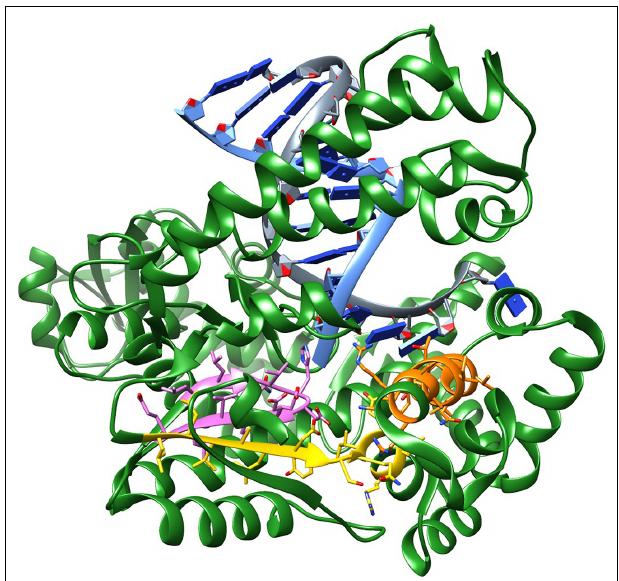
FIGURE 1 | Structure of Taq DNA polymerase showing the conserved motifs: (A) (LLVALDYSQIELR) – yellow; (B) (RRAAKTINFGVLY) – orange; (C) (LLQVHDELVLE) – pink. PDB ID 4DLG, which includes Taq beginning from the RNaseH portion till the end, in complex with a DNA primer and a DNA template, halted by/at a